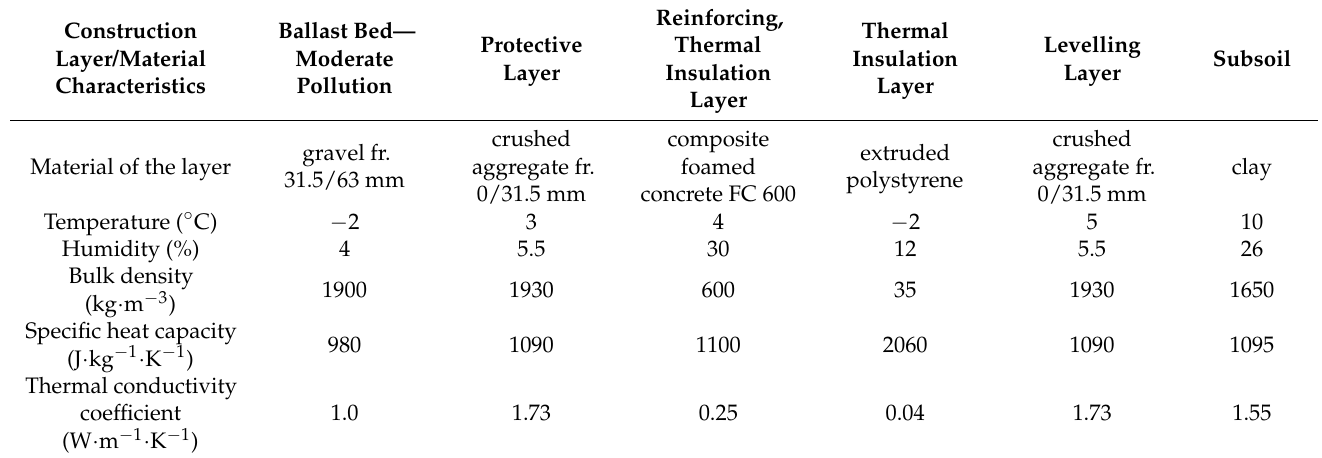
Table 6. Input parameters of numerical modelling—material characteristics.